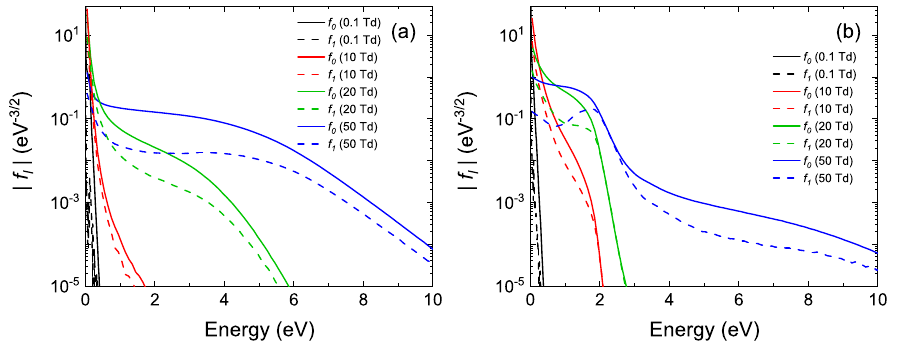
Figure 6. Zeroth (solid line) and first order (dashed line) Legendre polynomials coefficients calculated from MCF at different reduced electric fields for ( a ) a highly reduced composition of gases, including CH 4 , NH 3 and H 2 O in a ratio of 0.7:0.2:0.1 and ( b ) a mildly reduced composition of gases, including N 2 , CO 2 , CO, H 2 O and H 2 in the ratio of 0.7:0.2 for N 2 /CO 2 with traces of CO, H 2 O and H 2 in fractions of 0.05, 0.025 and 0.025,